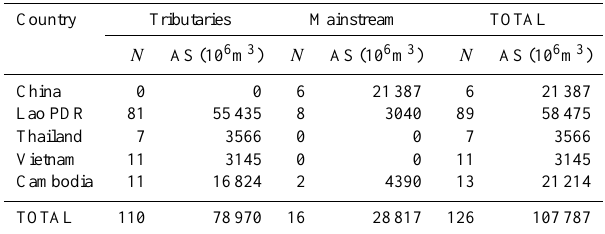
Table 1. Existing, under construction, and planned reservoirs in different Mekong countries, based on Mekong River Commis- sion (2009) for the Lower Mekong Basin, and ADB (2004) for Chi- nese part of the basin. N = number of reservoirs, AS = volume of active storage